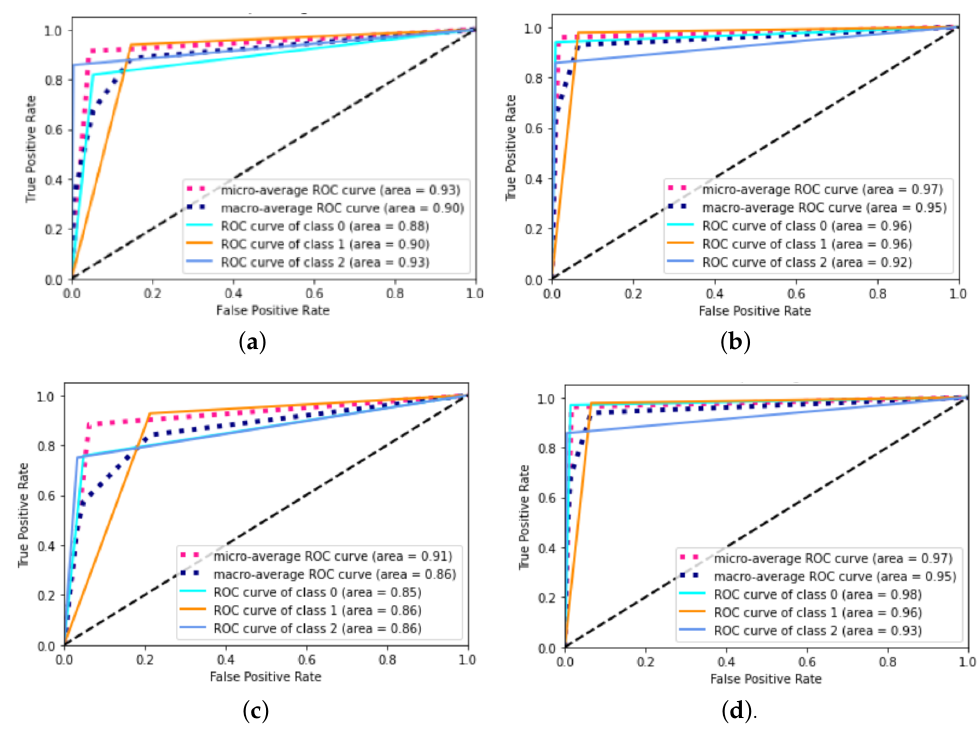
Figure 8. ROC Curve comparison of the proposed scheme. ( a ) DT, ( b ) RF, ( c ) ANN, and ( d ) XGBoost